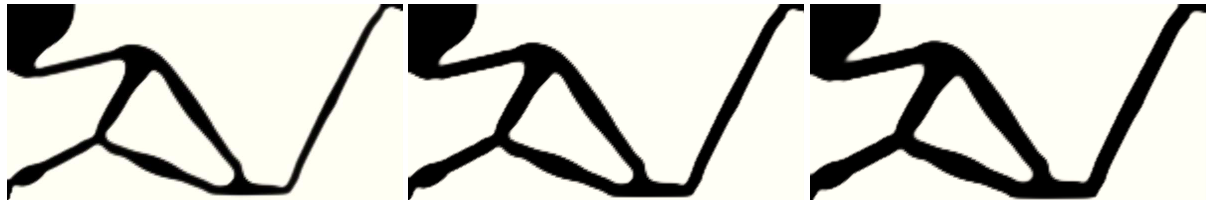
Figure 5. Three threshold projections, eroded, intermediate and dilated, obtained with thresholds η = 0 . 6 , 0 . 5 and η = 0 . 4, respectively. The design is obtained using large displacements robust optimisation formulation with threshold η ∈ U [0 . 3 , 0 . 7] and volume constraint 30% of the original volume imposed on the dilated projection at η = 0 . 3. The objective is E[ c ] = − 8 . 96 µ m, the standard deviation is STD[ c ] = 5 . 80, the number of the integration points is 31, and the projection parameter is β = 32.